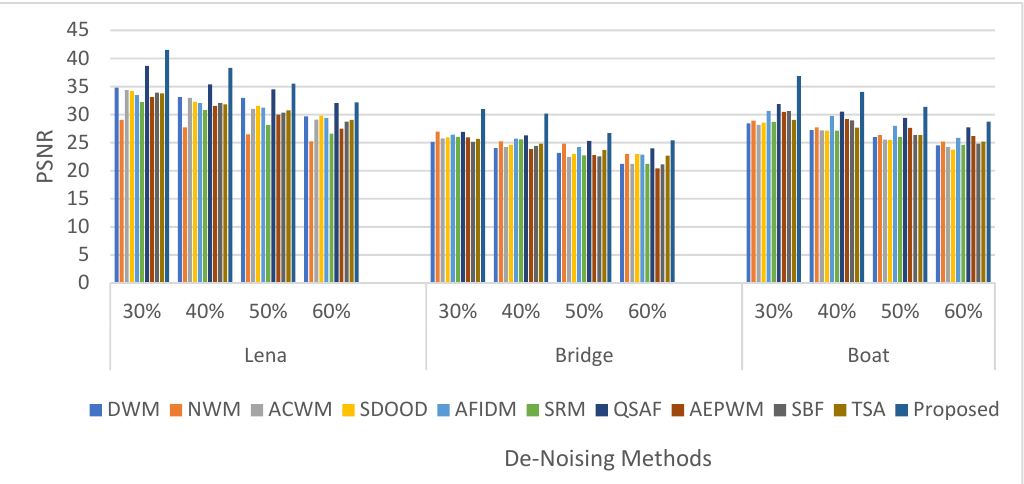
Figure 7. Shows a comparison in terms of PSNR of different methods for Lena, Bridge and Boat images corrupted with noise ratios of 30, 40, 50 and